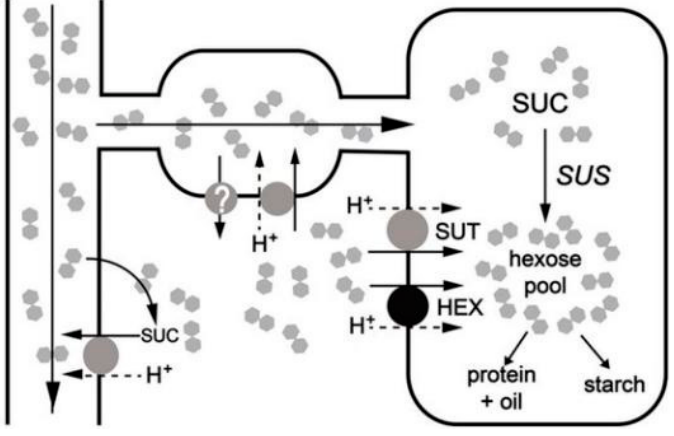
Figure 5. Sucrose transportation in sink tissue [9].